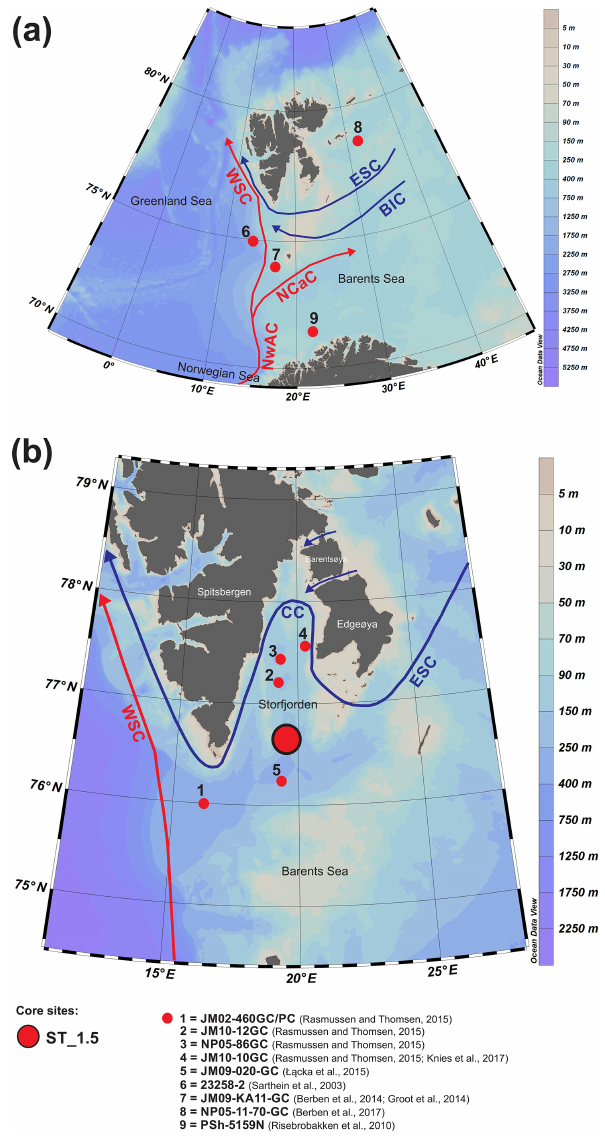
Figure 1. The modern oceanography of the study area (a) and the location of the studied core ST_1.5 (b) and the other cores discussed in this paper (a, b) . Abbreviations of main surface currents: